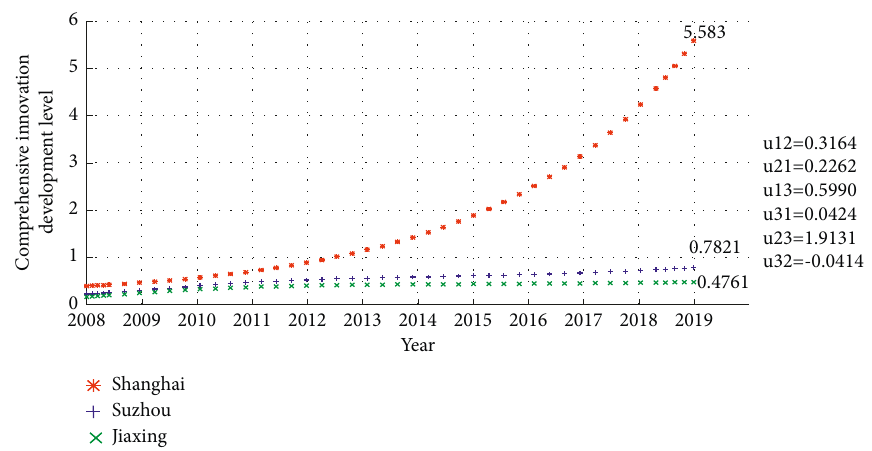
Figure 4: Evolution trend of comprehensive innovation development level under reciprocal